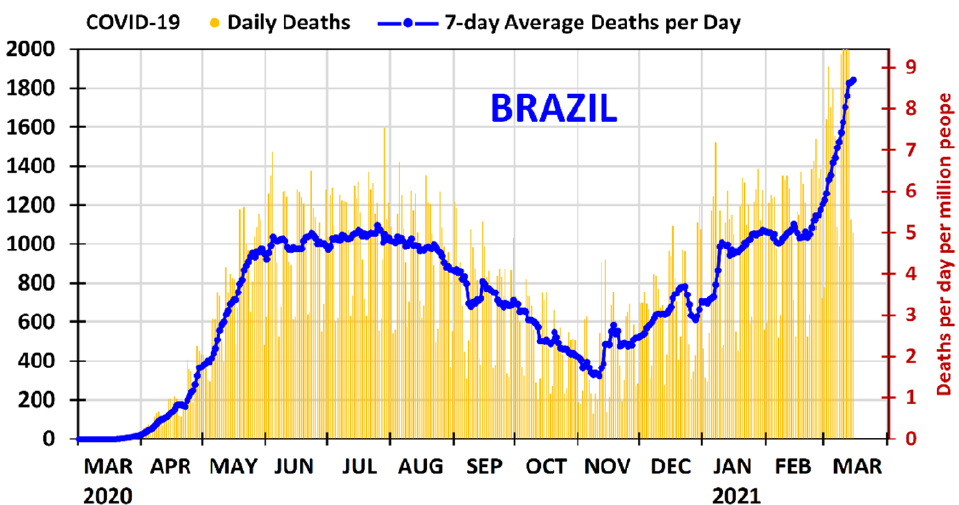
Figure 2. Daily deaths and 7-day average deaths per day of COVID-19 in Brazil from 1 March 2020 to 15 March 2021. The deaths per day per million people can be found using the secondary vertical axis on the